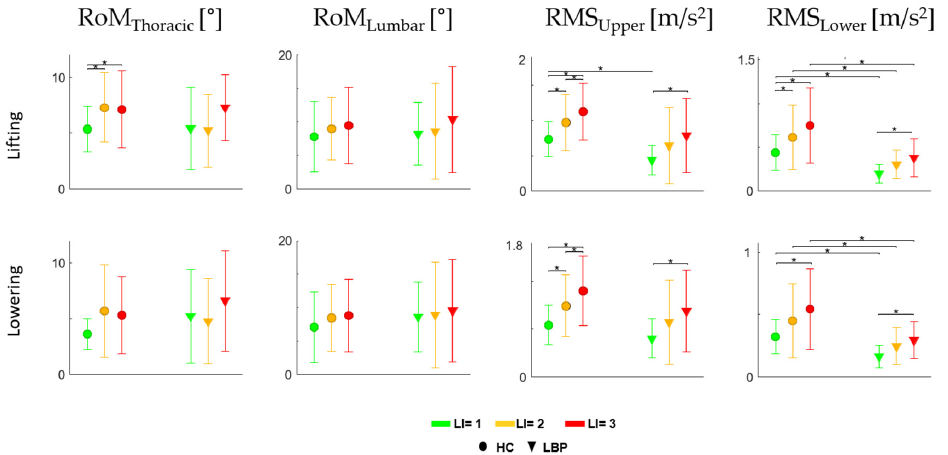
Figure 5. Mean ± SD for each risk level in both groups for the Range of Motion (RoM) of Thoracic (RoM Thoracic ) and Lumbar (RoM Lumbar ) regions and the Root mean square of the acceleration of upper (RMS upper ) and lower trunk (RMS lower ) values considering all repetitions within the entire session, in lifting and lowering phases. [* statistical significance ( p < 0.05)].